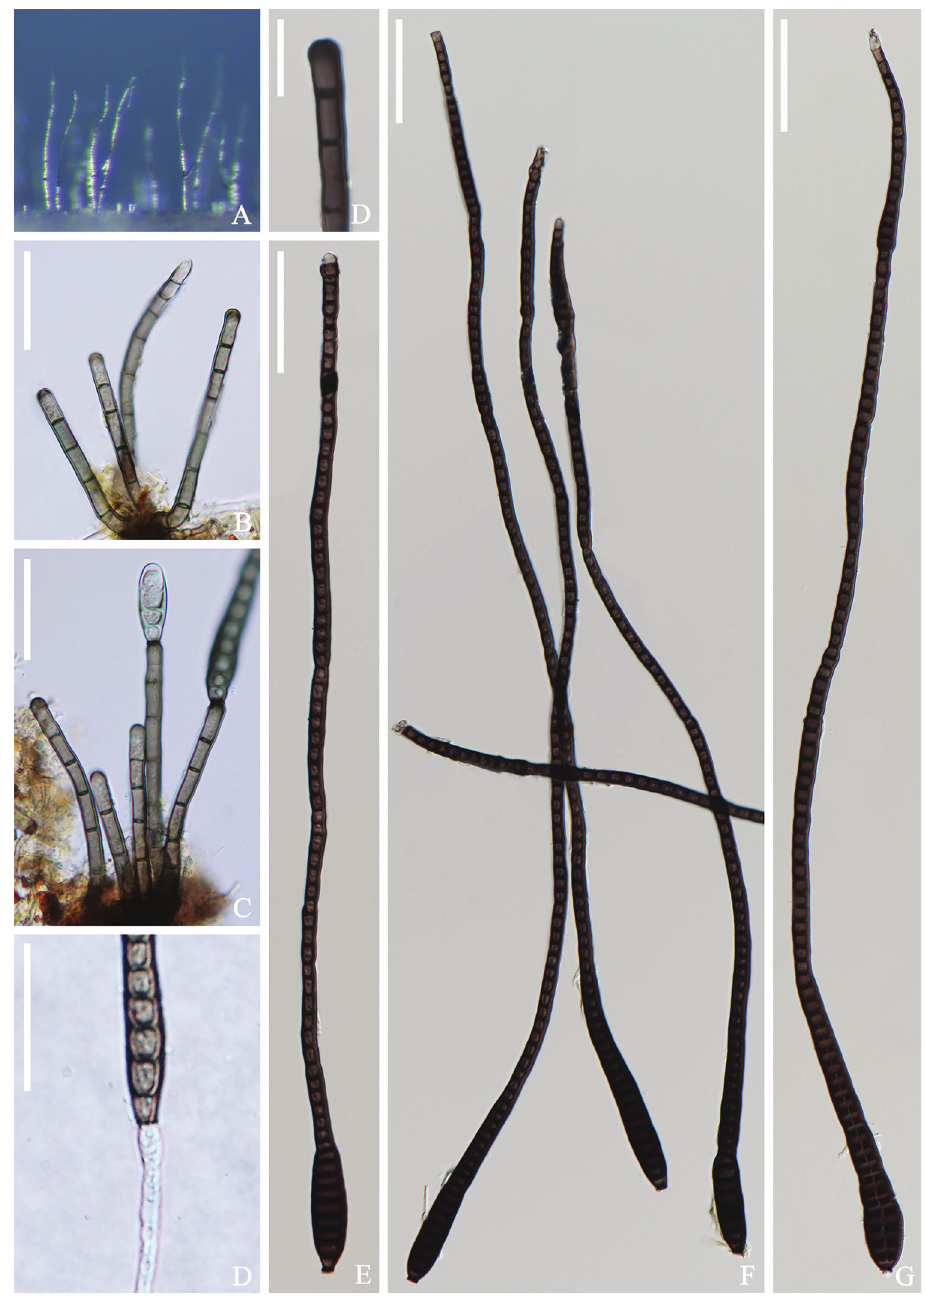
Figure 2. Distoseptispora bangkokensis (MFLU 21-0110, holotype ) A colonies on the substratum B co- nidiophores C conidiophores with conidia D conidiogenous cell E-G conidia H germinating conidium Scale bars: 20 μm ( B, C, H ); 10 μm ( D ); 50 μm ( E-G